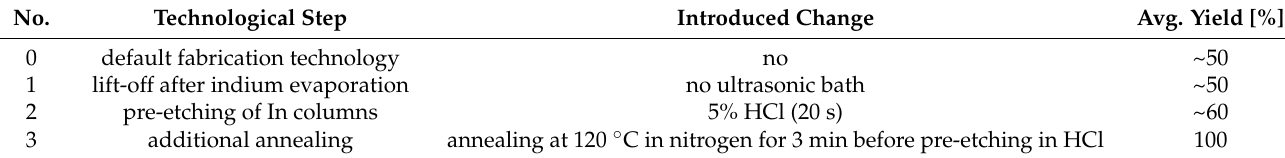
Table 2. Optimization of indium bump fabrication with wet pre-etching in hydrochloric